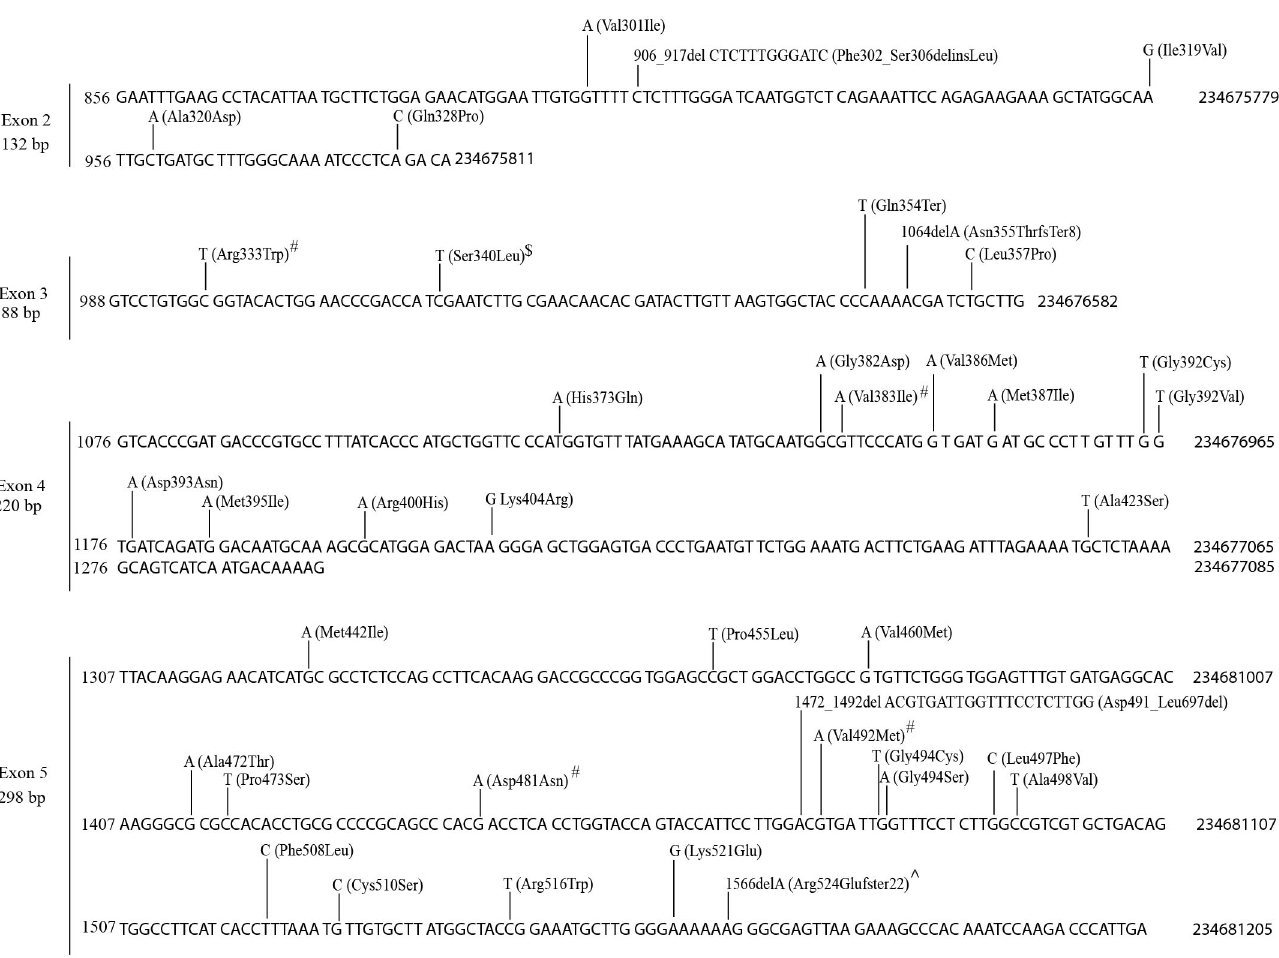
Figure 2. Mutations within the coding region of the shared UGT1A exons 2–5 in TCGA tumors. Data shown are the NCBI reference sequence (4 exons, 738 bp) for UGT1A exons 2–5 with genomic positions (GRCh37/hg19) indicated at the right, and the positions at cDNA (at left) and protein (above sequence) levels for exons 2–4 (defined by the UGT1A10 reference sequences: NM_019075.4 and NP_061948.1) and exon 5 (defined by the UGT1A4 reference sequences: NM_007120.3 and NP_009051.1). Mutations (missense, nonsense and small indels) and the resulting changes at the protein levels are indicated above the reference sequence. Recurrent mutations are indicated by # (twice), $ (three times) and ∧ (six times).